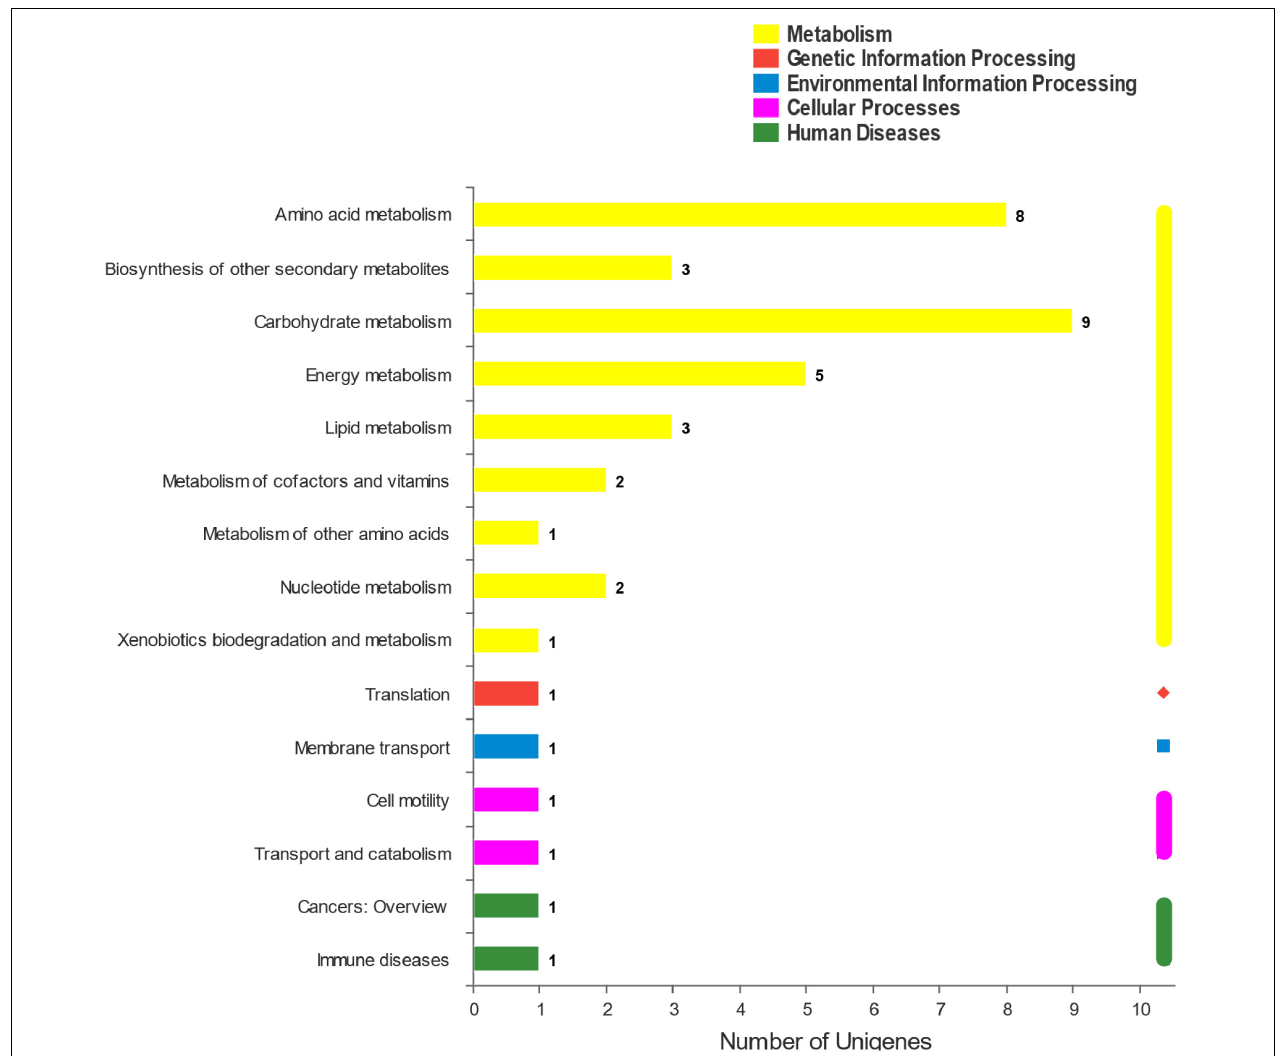
FIGURE 5 | KEGG pathway classification of DEGs between CTR and FUR exposure biofilms. The horizontal coordinate represents the number of DGEs annotated to each subcategory. Control (CTR), P. marina ECSMB14103 biofilm prepared on a sterile glass slide without adding FUR; FUR, 10 4 M FUR-treated P. marina ECSMB14103